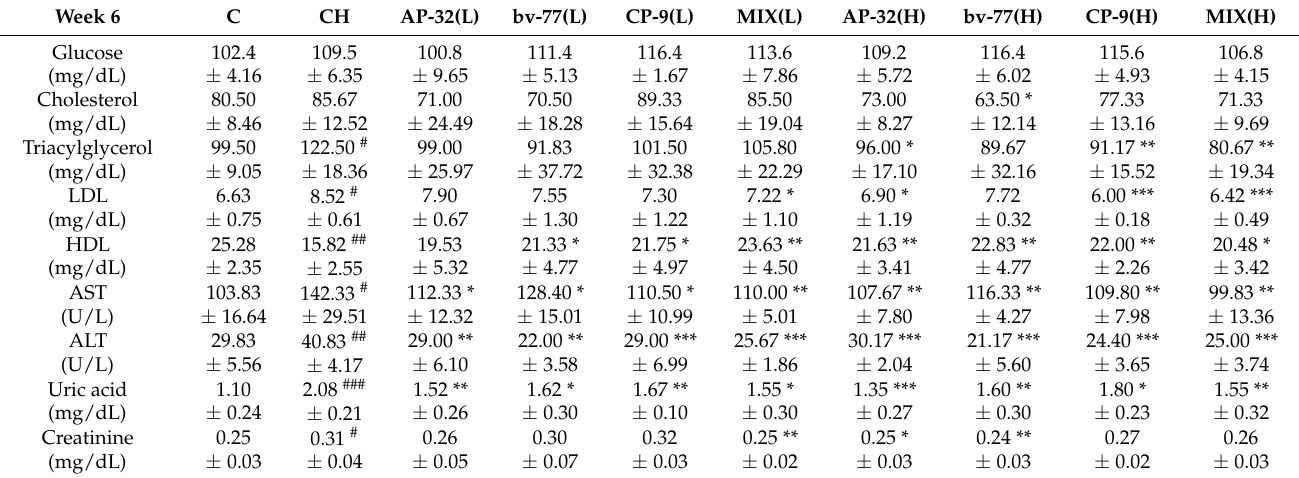
Table 1. Analyses of blood chemistry during probiotic intervention at week 6.